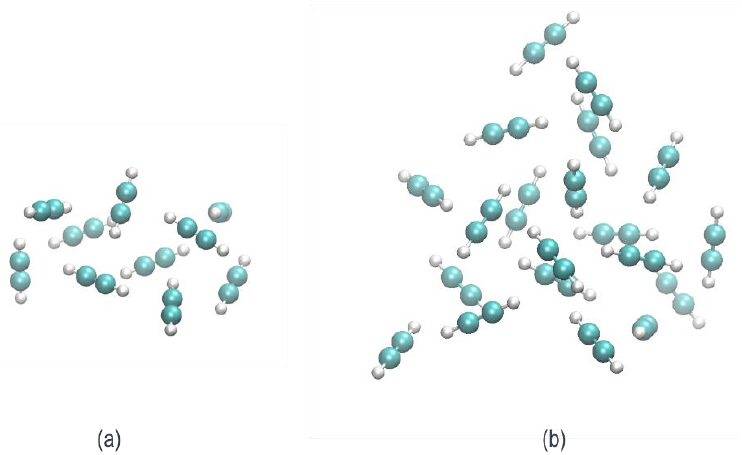
Figure 1. Pure neutral acetylene clusters consisting of ( a ) 10 units of acetylene (decamer) and ( b ) 20 units of acetylene (eicosamer).